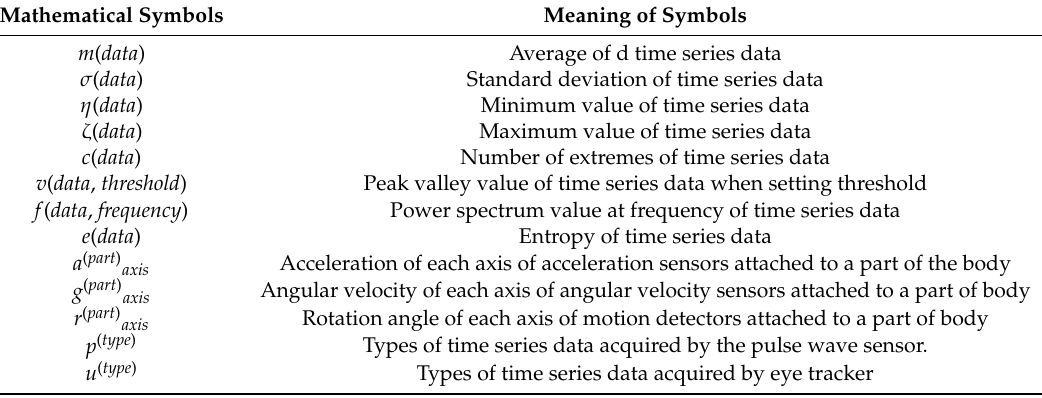
Table 3. Correspondence table of each feature quantity and mathematical